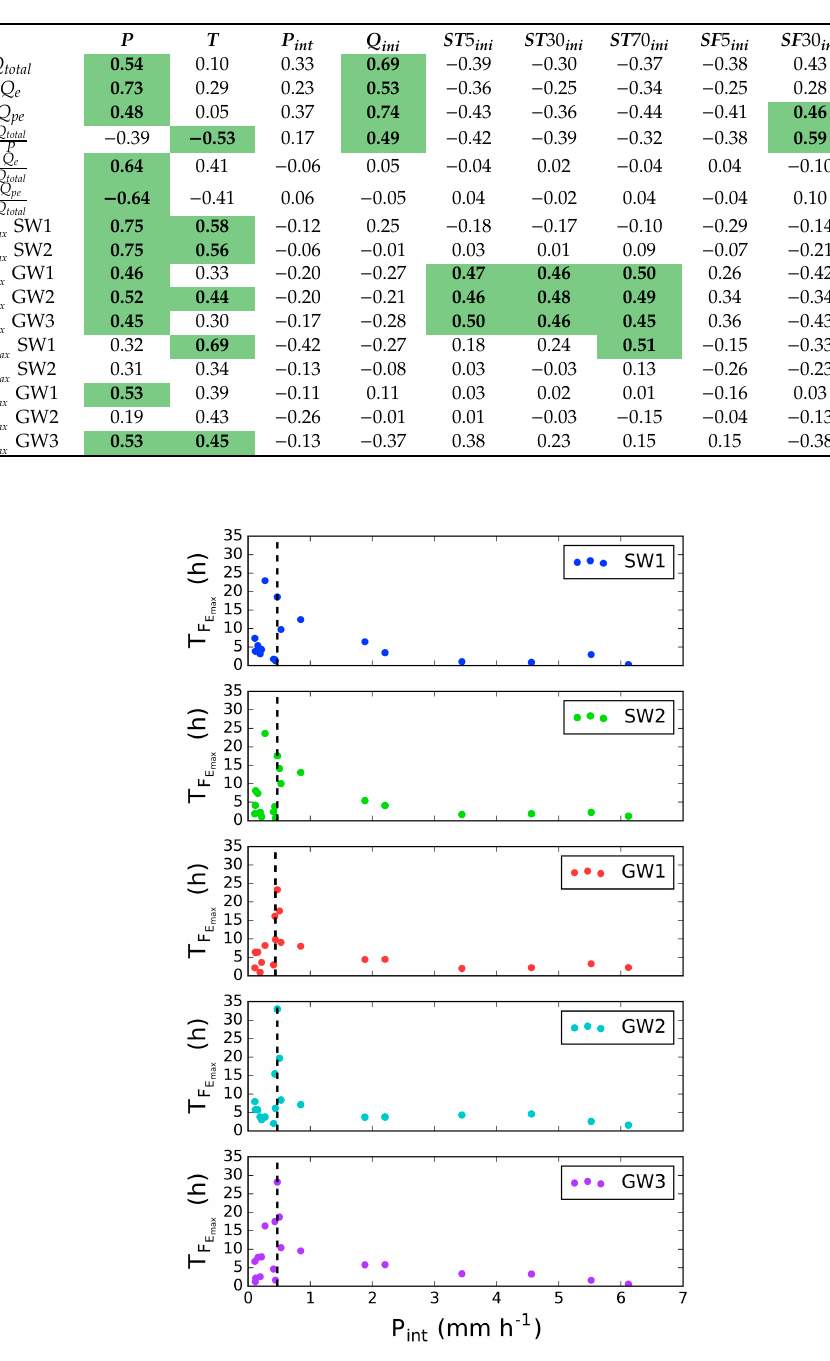
Figure 8. Response time T F Emax of stream water and groundwater sources versus mean precipitation intensity P int . The dashed line is the threshold, at which the response time decreased with increasing mean precipitation intensity. The threshold value was 0.47 mm h − 1 for SW1, SW2, GW2, and GW3 and 0.44 mm h − 1 for GW1.